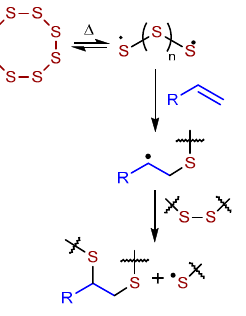
Scheme 1. Thermal reaction of elemental sulfur to produce radicals allows their subsequent reaction with olefins to form cross-linked high sulfur-content materials (HSMs) by inverse vulcanization.